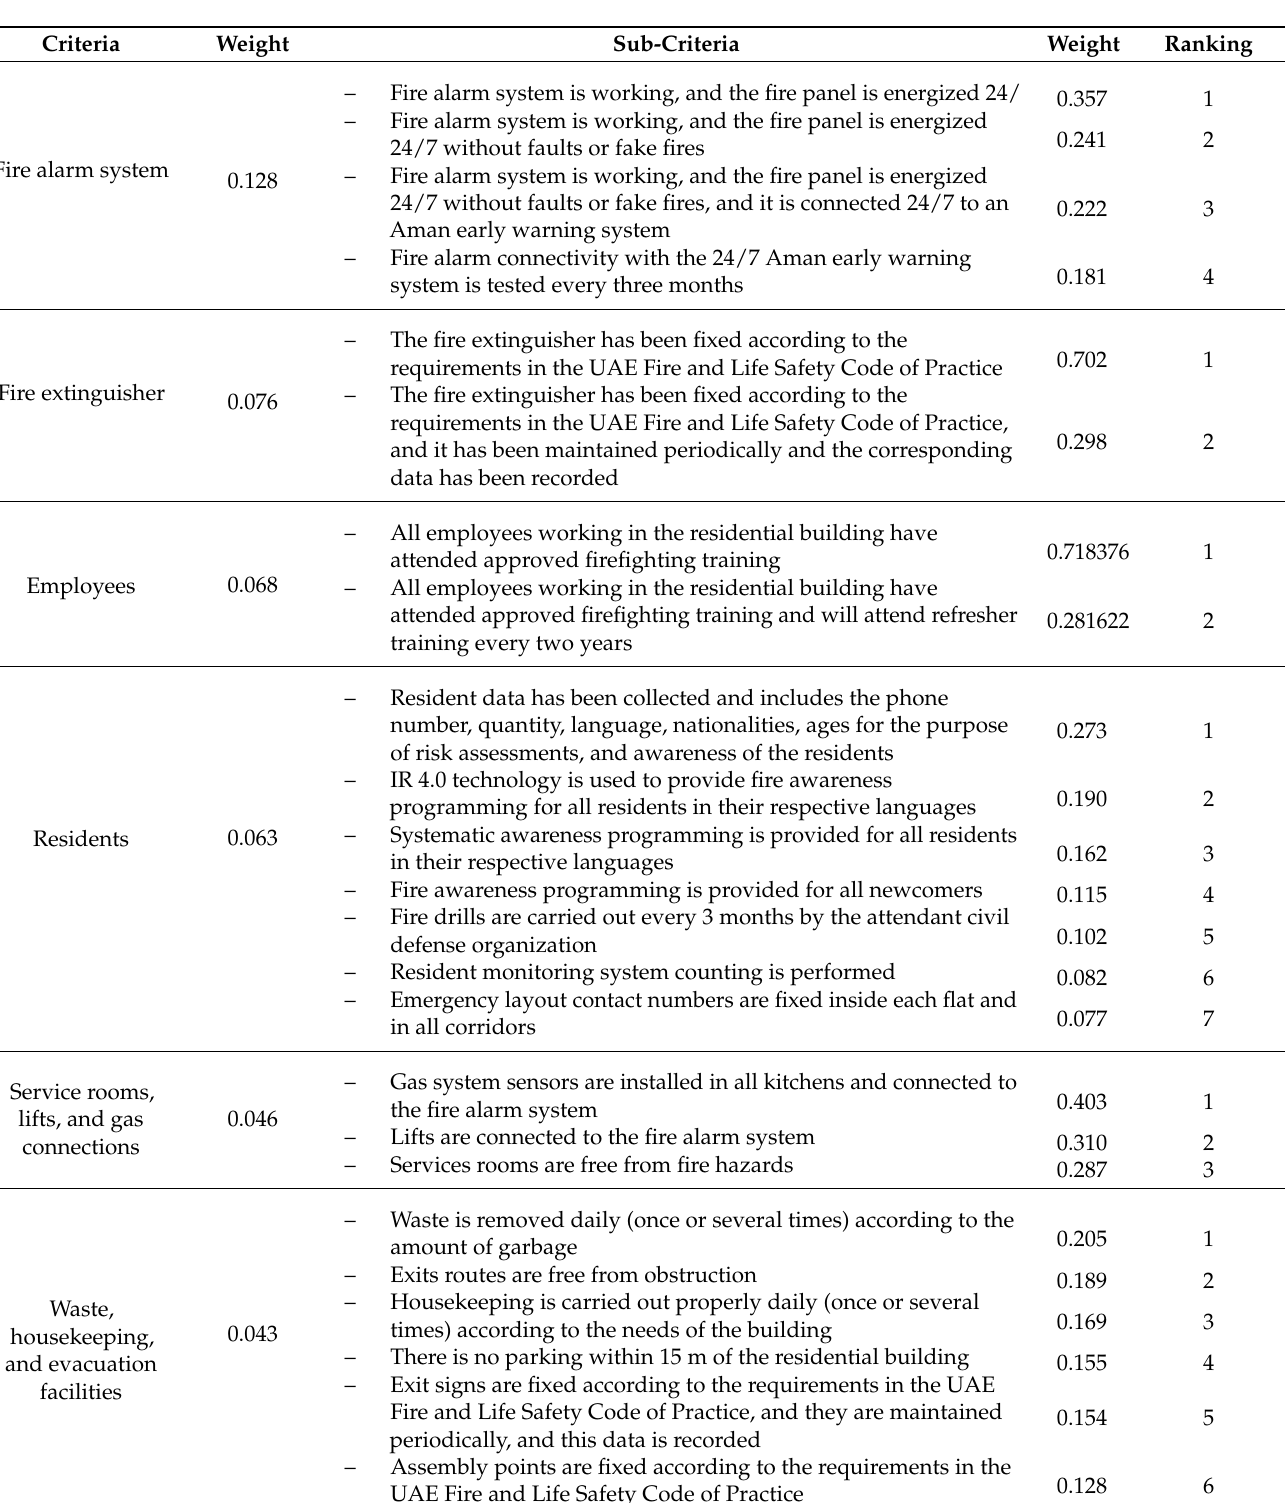
Each sub-criterium holds a specific weight in the fire management system for high-rise buildings, and the weighting reflect the effect of the sub-criterium upon the overall fire measures. The calculated compliance ratings of sub-criteria reflect the levels of compliance with the fire indexes, according to the percentages shown in Table 3. HRBFI